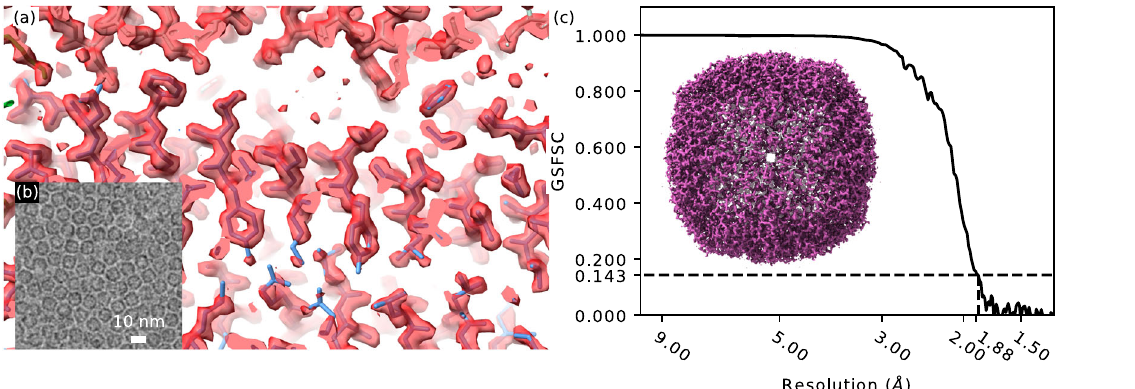
Fig. 7 MeasureIce assisted single particle reconstruction of Equine apoferritin. a Comparison of Cryo-EM reconstruction with structure model from Naydenova et al. 1 , b a representative micrograph, with a 1 nm low-pass fi lter, and c gold-standard Fourier shell correlation (GSFSC) assessment of map resolution with a rendering of the reconstructed molecular map inset.